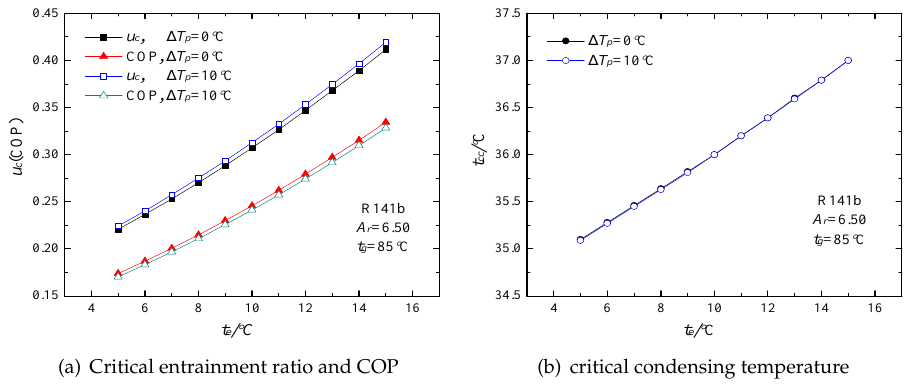
Figure 20. Critical entrainment ratio, COP and critical condensing temperature versus evaporating temperature using R141b as a working fluid.